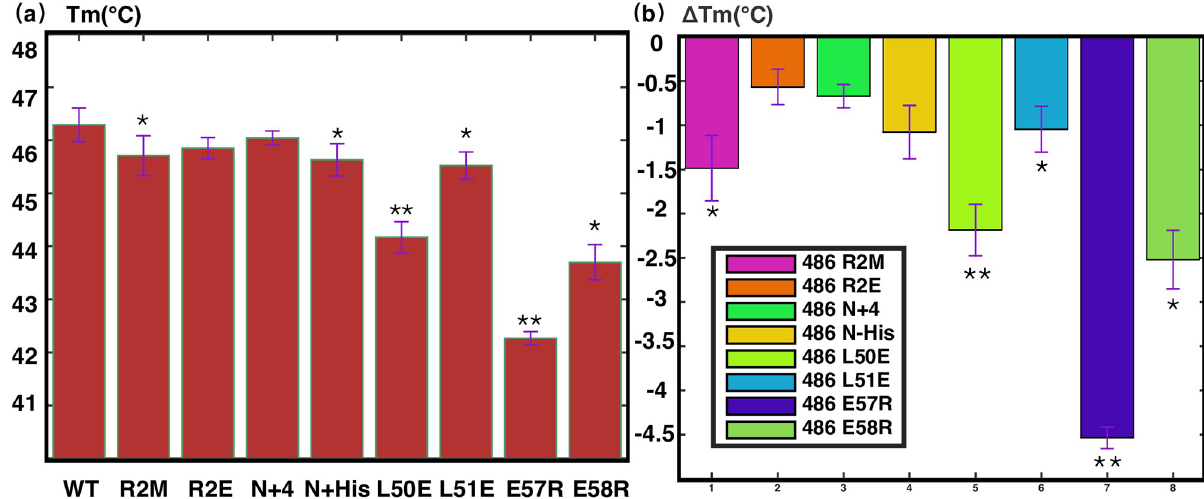
Fig 10. Results from fluorescence thermal shift assay (FTSA) of PRC1 1–486 and its mutants (bar graph representation of data in Table 3). (a) Bar graph showing the mid-denaturation temperature (Tm) of wild-type PRC1 1–486 and its mutants. The name of each mutant is labeled on the x-axis of the figure, R2M refers to Δ 1R2M. (b) Changes in Tm ( Δ Tm) of mutants compared with wild type. The mutants are color-coded according to the figure legend. Graphs were produced in MATLAB; the mean and standard deviation of Tm were calculated from four parallel runs of each experiment. single star indicates statistical significance (p < 0.05) and double star indicates strong significance (p < 0.01).